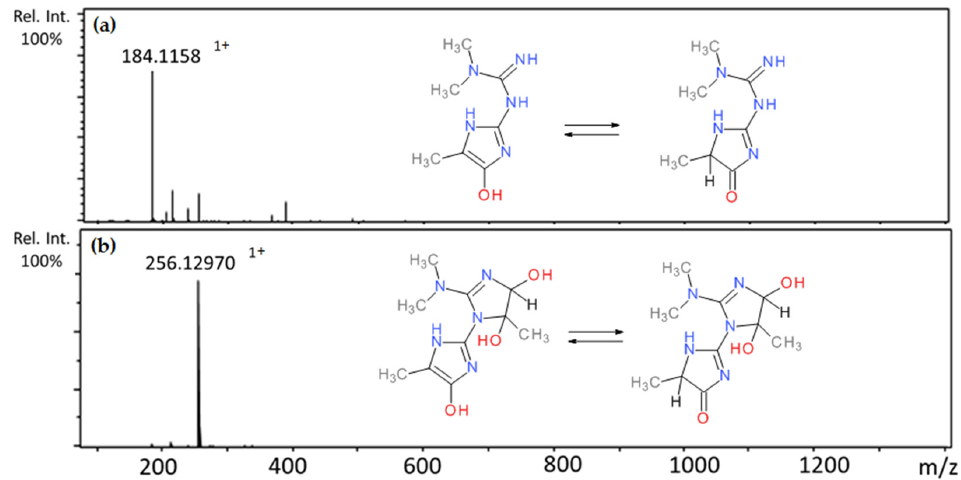
Figure 9. Mass spectra of methylglyoxal adducts with metformin after 1 h incubation in pH 7.4 phosphate buffer solution at 37 °C and their proposed chemical structure (isomers): ( a ) mono-MGO-metformin; ( b ) di-MGO-metformin ; other isomeric forms are also possible.